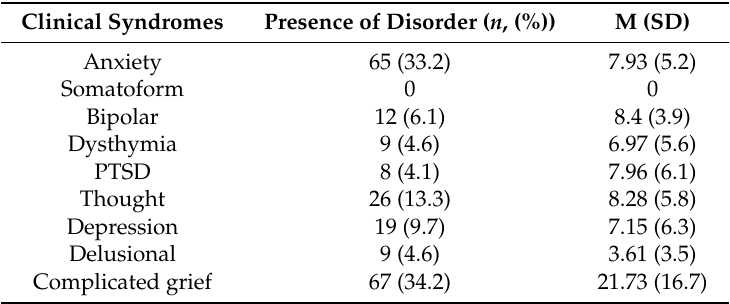
Table 1. Occurrence of psychopathological syndromes. PTSD = post-traumatic stress disorder. M = the average of the direct scores. SD = standard